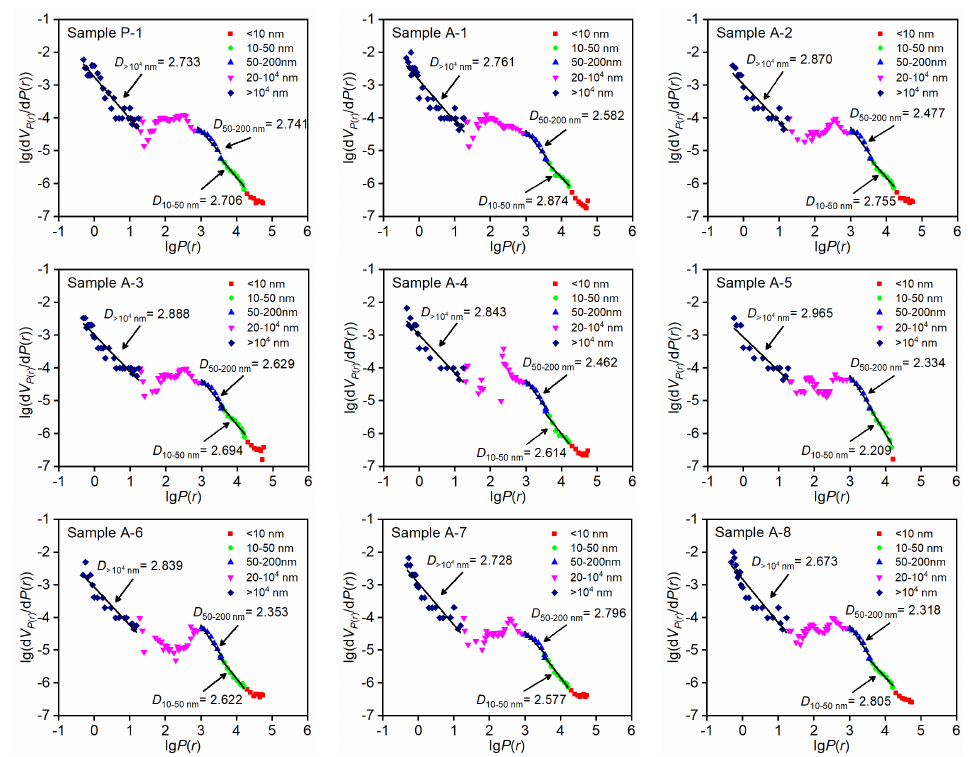
Figure 2: Logarithm plot of lg(d V P ( r ) /d P ( r ) ) and lg P ( r ) in the different pore size range under power-controlled ultrasonication.